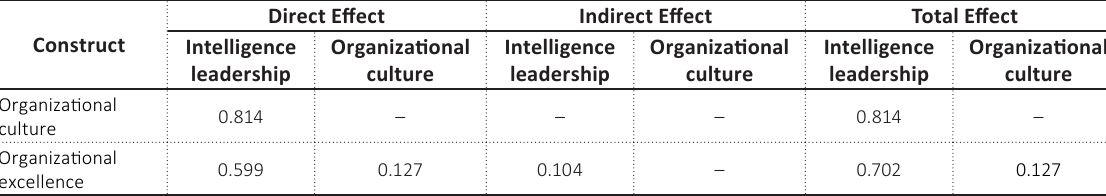
Table 10. Direct and indirect effects coefficients